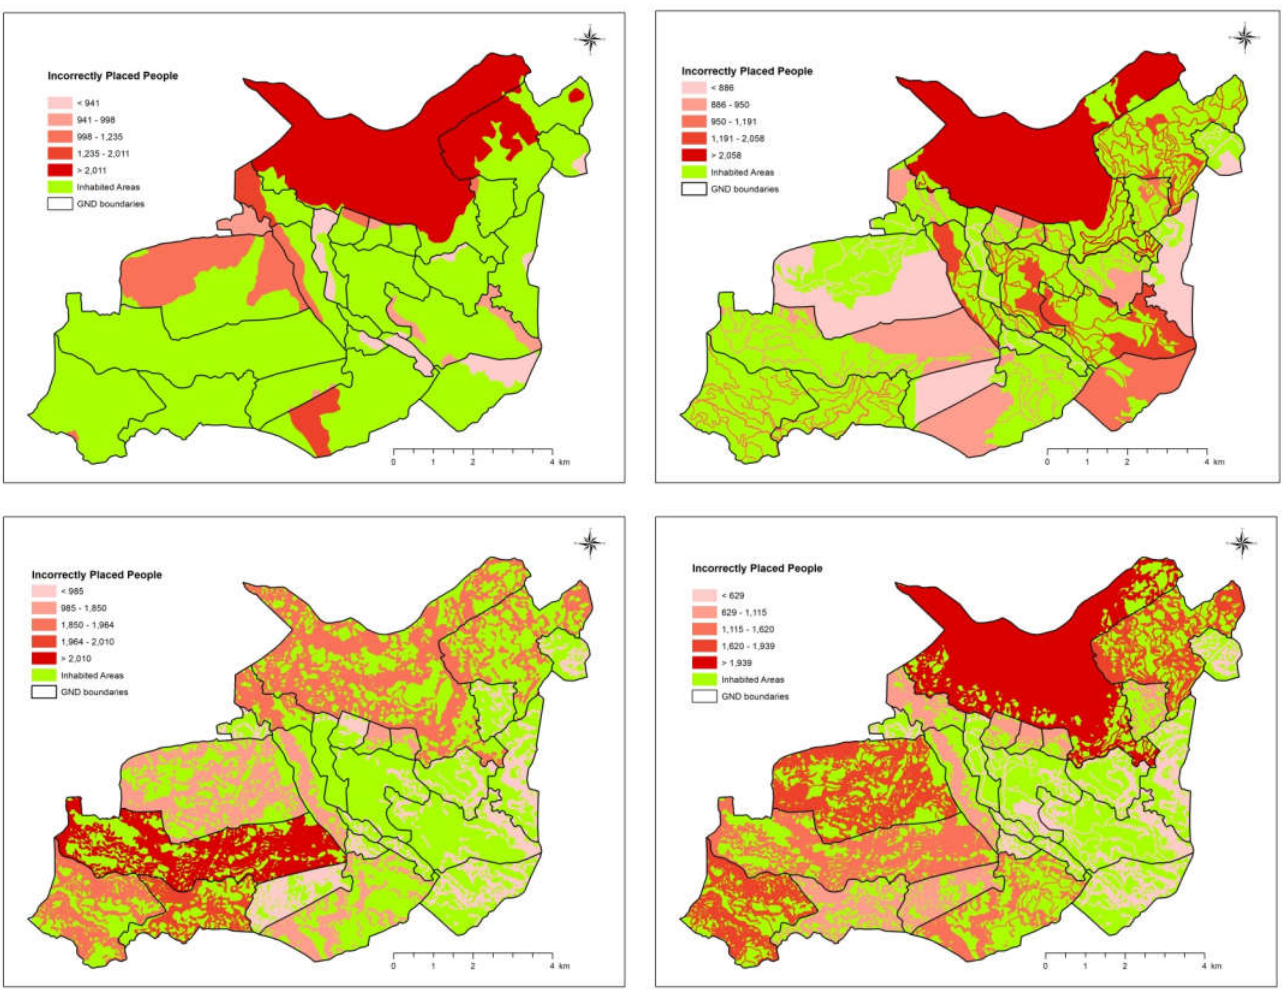
Figure 10. Incorrectly placed people by different dasymetric approaches: upper left for altitude-based; upper right for land use-based; bottom left for slope-based; bottom right for a combined dasymetric approach.